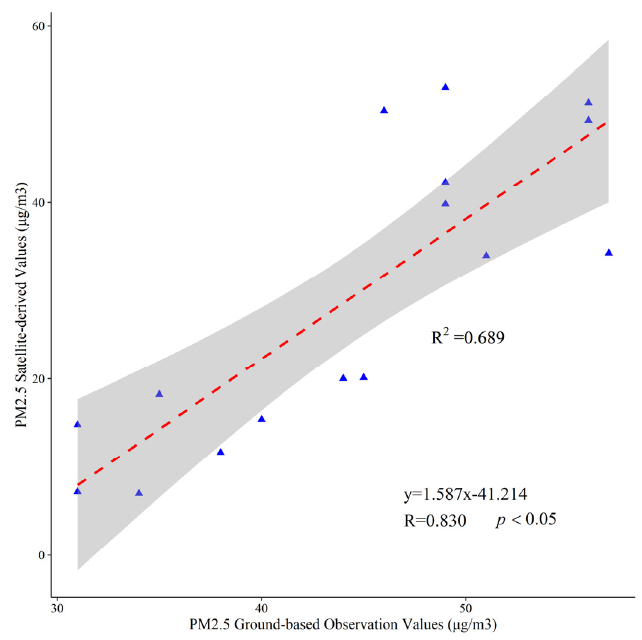
Figure 2. Linear correlation between PM 2.5 ground-based observation values and satellite-derived values.